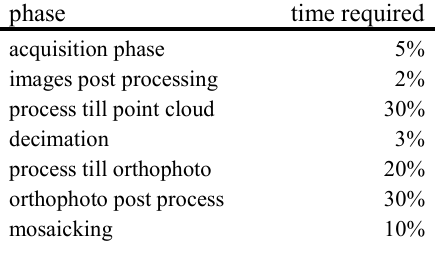
Table 1. Time demand of the different phases considering a total processing time of about 6 months with 1